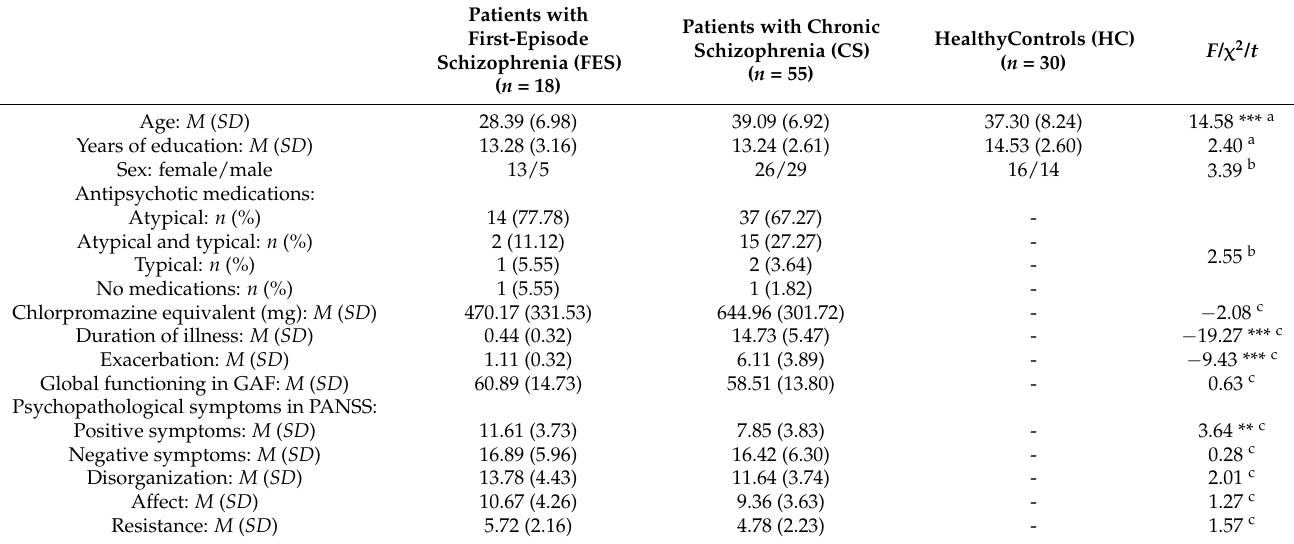
Table 1. Demographic and clinical characteristics of all